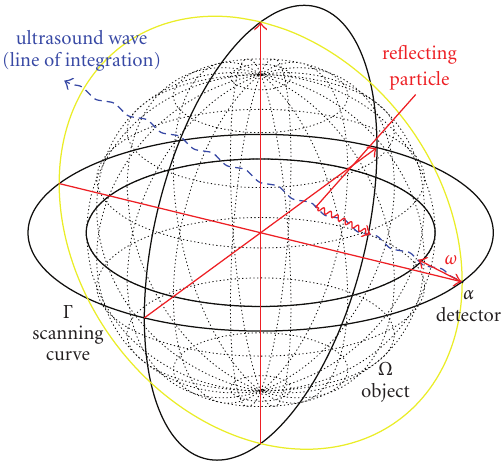
Figure 19: Measurement setup using all three orthogonal circles as scanning curve Γ , one in each plane { x i = 0 } , i =